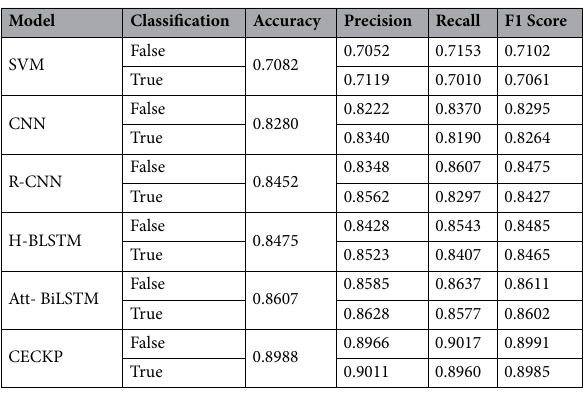
Table 3. Experimental results for CECKP model and comparison